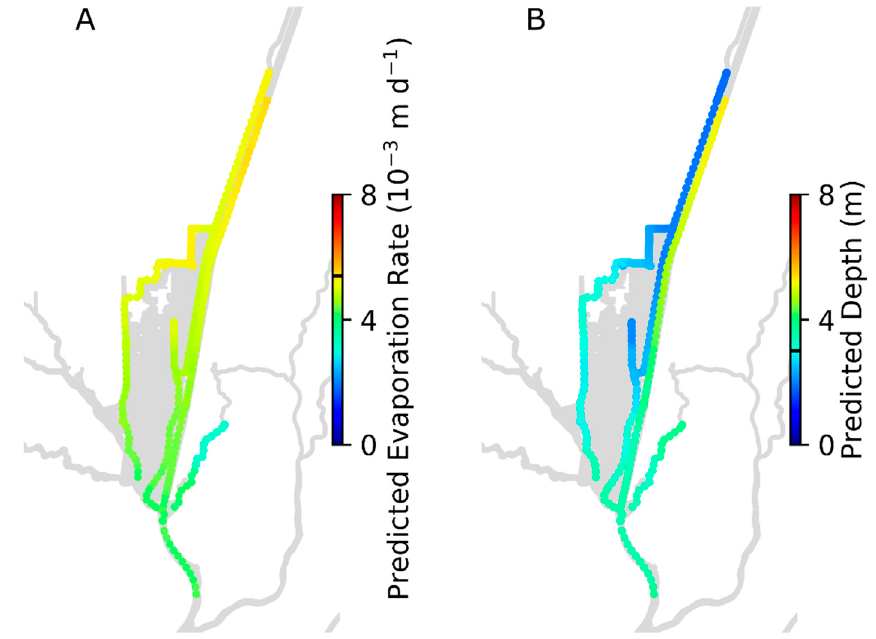
Figure 11. ( A ) Evaporation rate estimated using predicted age, with assumed evaporation rate of 0.00054 m d − 1 shown with a black line in the colorbar. ( B ) Predicted representative depth estimated from predicted fractional evaporation, evaporation rate and predicted age, with the assumed depth of 3 m shown with a black line in the colorbar.